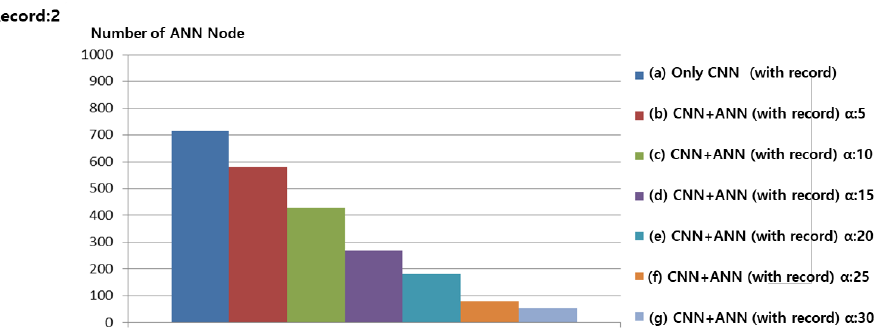
Figure 12. Number of ANN Nodes when Record was two.